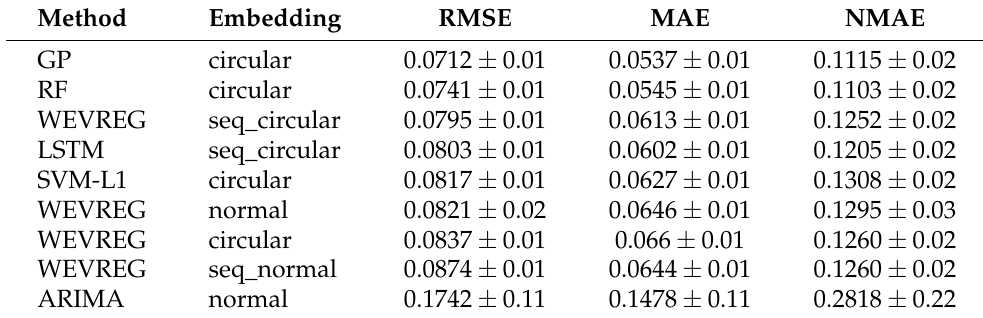
Table 7. Stores tickets prediction